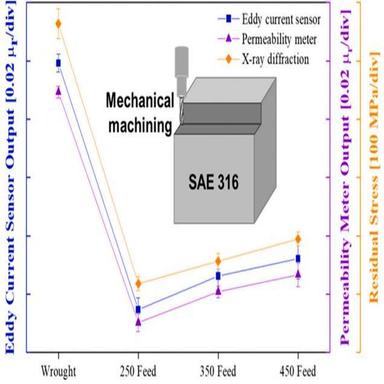
Permeability of mechanical machined specimen measured by the fiber optic current sensor and the magnet permeability meter, and residual stress of mechanical machined specimen measured by the X-ray diffraction.